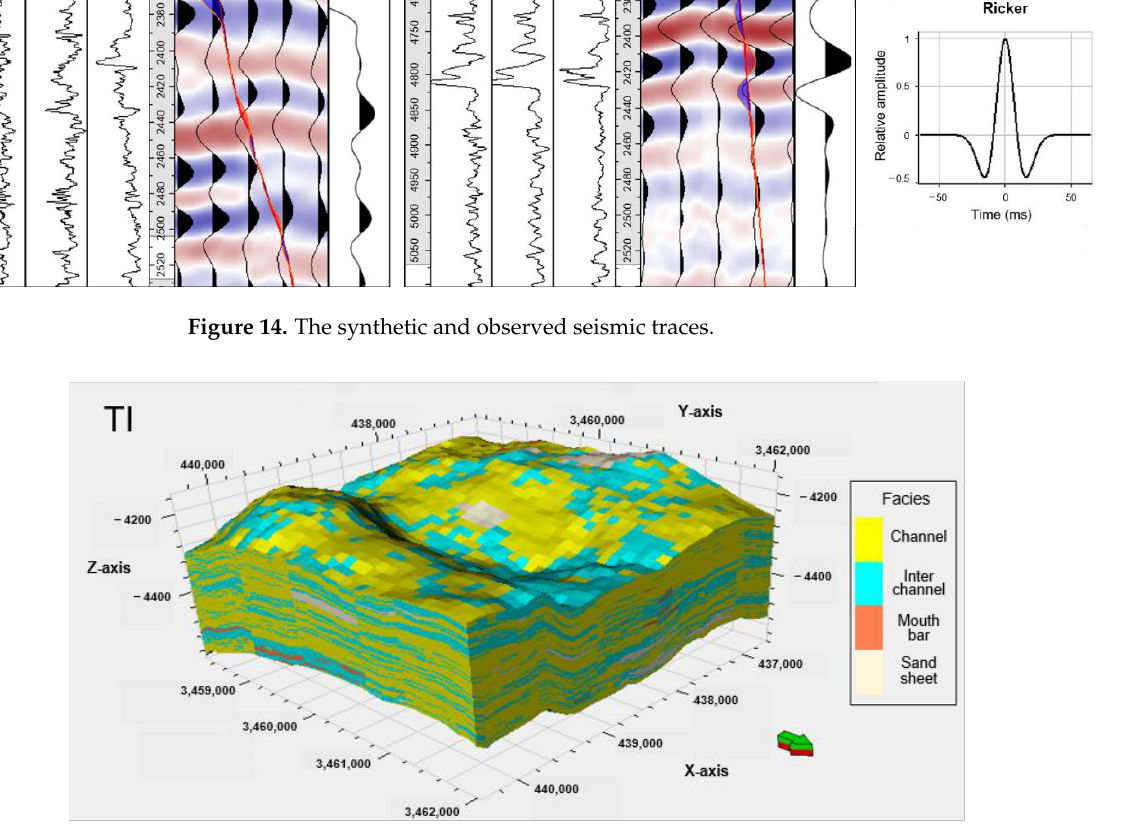
Figure 15. Training image of the inversion block.